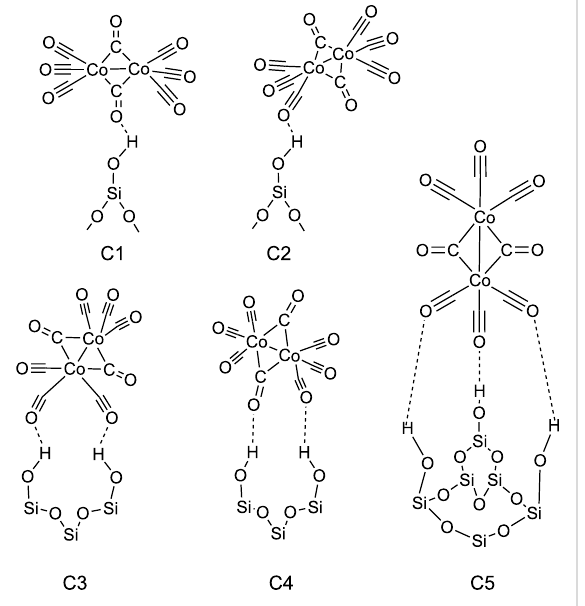
corresponding to an OH vacancy concentration of 11, 22 and 33%, were considered depending upon the orientation of Co 2 (CO) 8 on the surface [33]. In order to have the most stable bonding configuration of Co 2 (CO) 8 on these FOH-SiO 2 and POH-SiO 2 surfaces, five different orientations (C1 to C5 as shown in Figure 6) were considered. These orientations take into account the possible ways in which the precursor molecule can adsorb on the surface. The calculated adsorption energies for the different configura- tions of Co 2 (CO) 8 on FOH-SiO 2 surfaces range from − 0.26 to − 0.76 eV (Table 1) illustrating that the precursor molecule